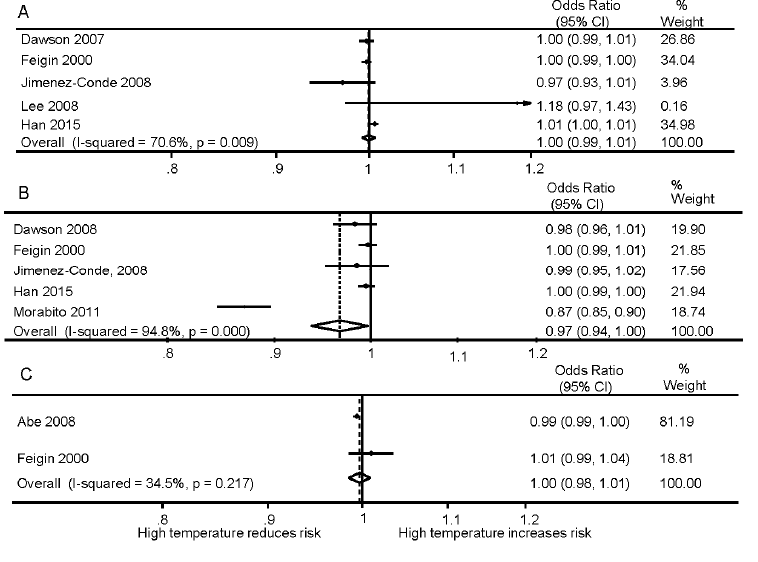
Figure 2. Meta-analysis of ambient mean temperature and stroke: ( A ) ischemic stroke; ( B ) intracerebral haemorrhage; ( C ) subarchnoid haemorrhage.